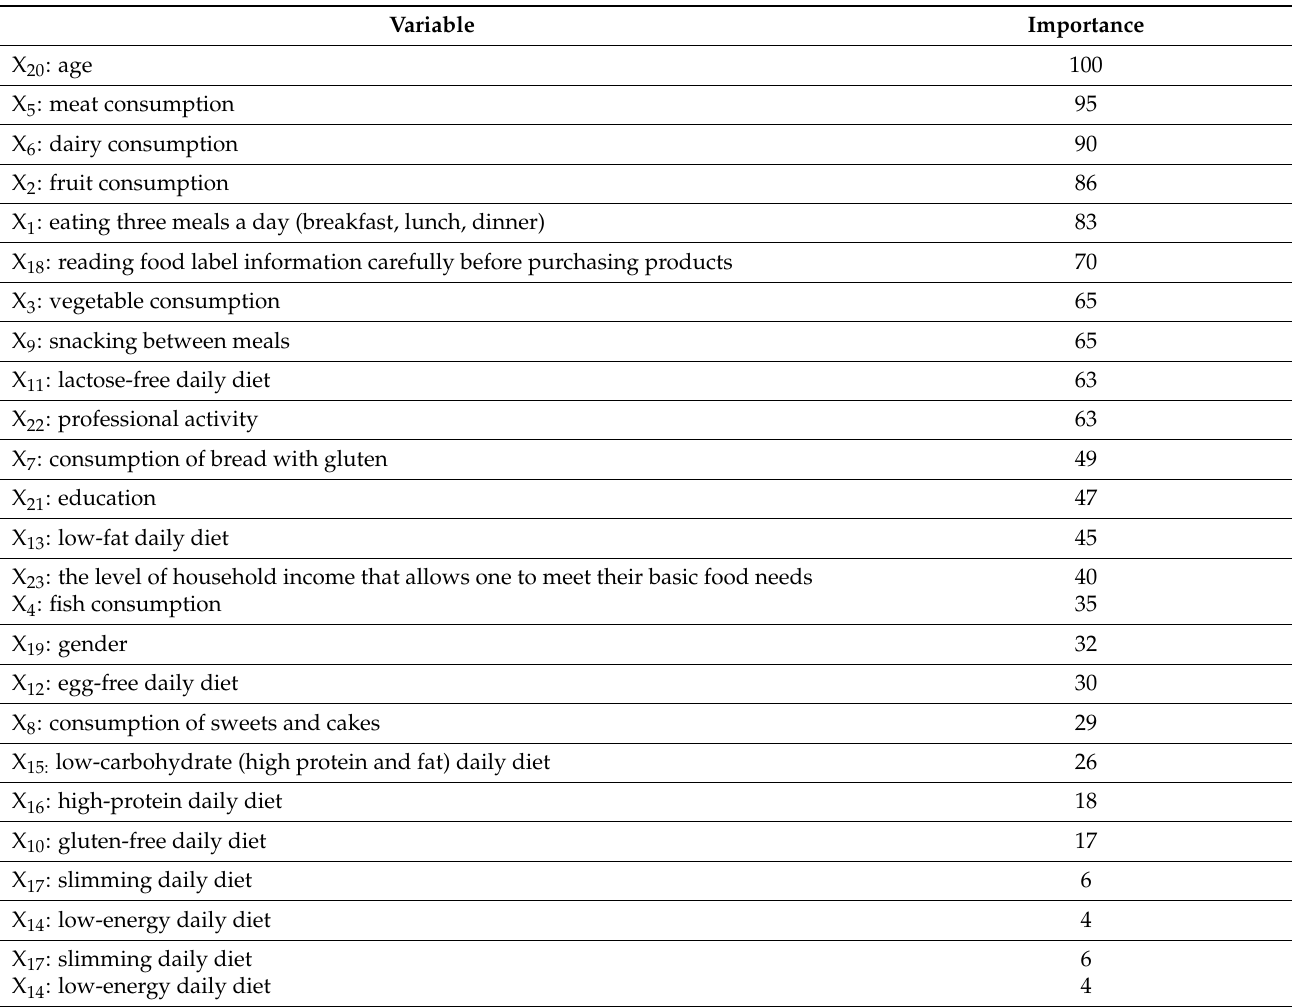
Table 4. Ranking of importance of variables for good or very good